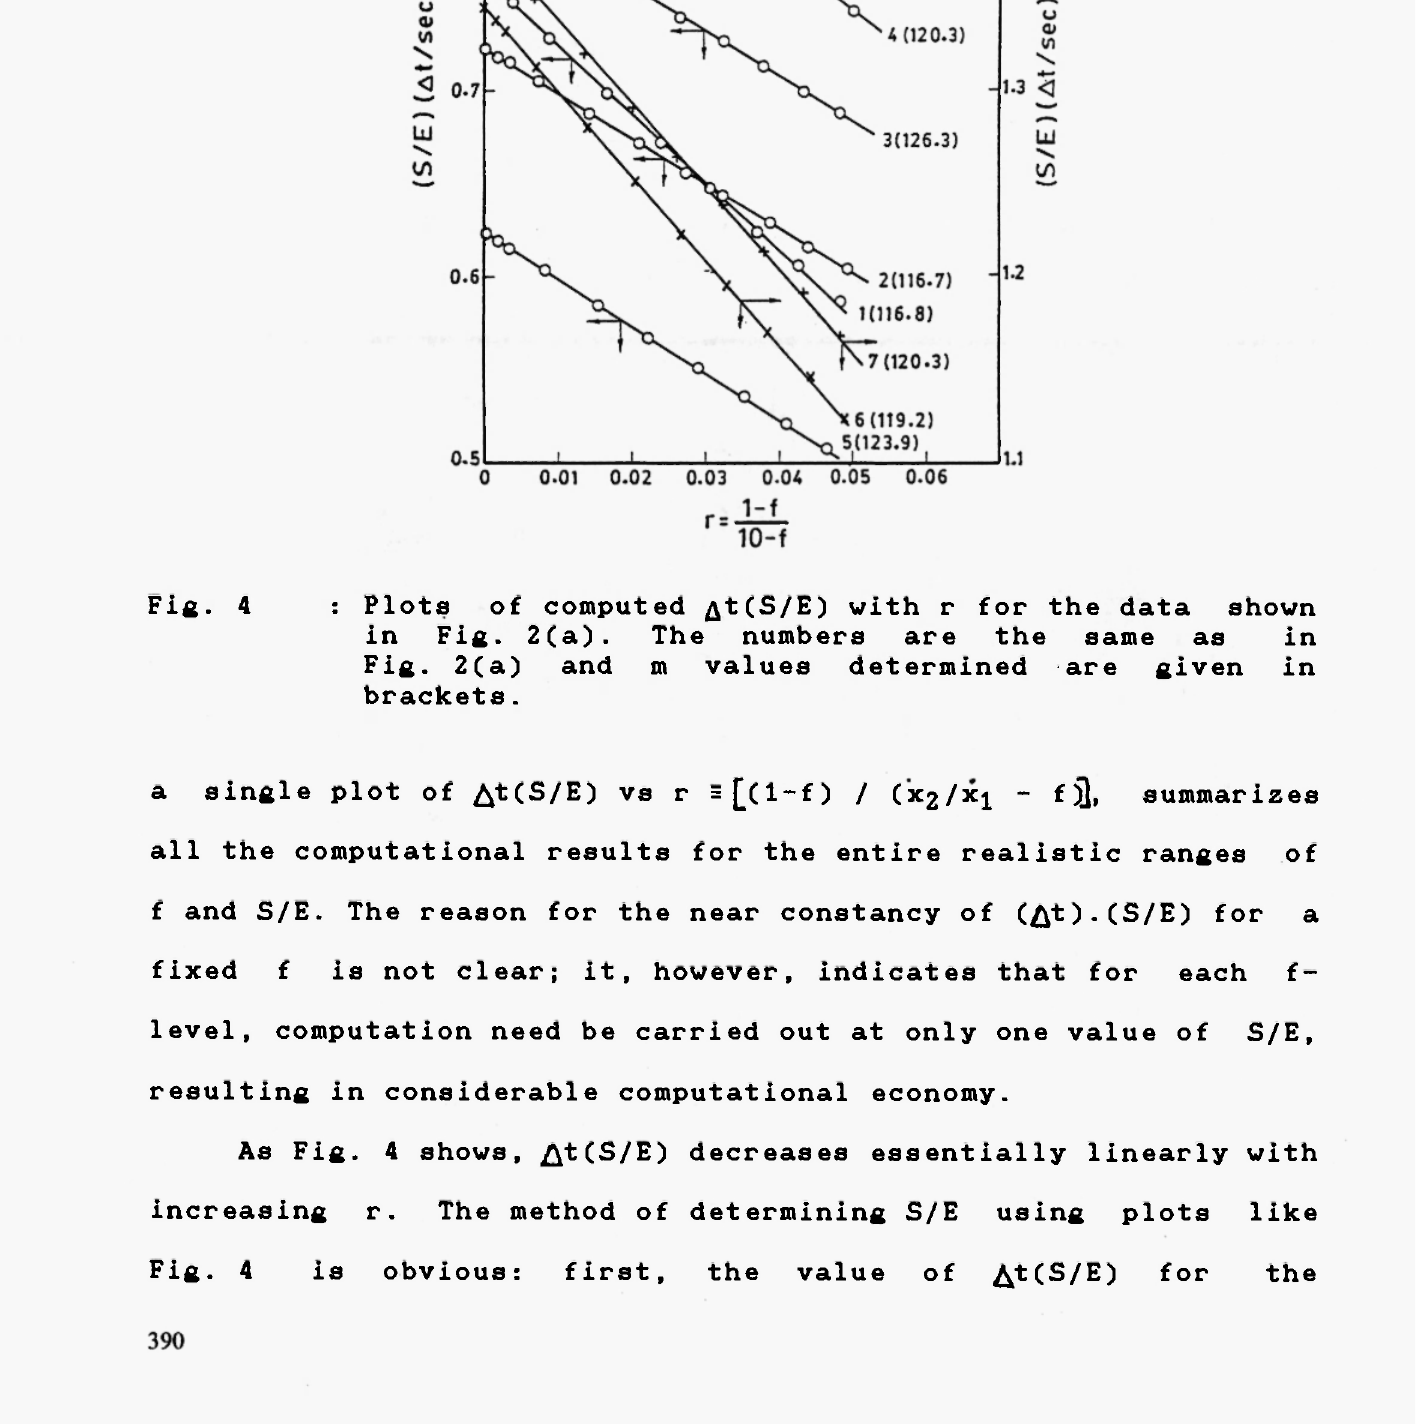
economy. linearly w i th using like first, the v a l ue of ^ t ( S / E) for